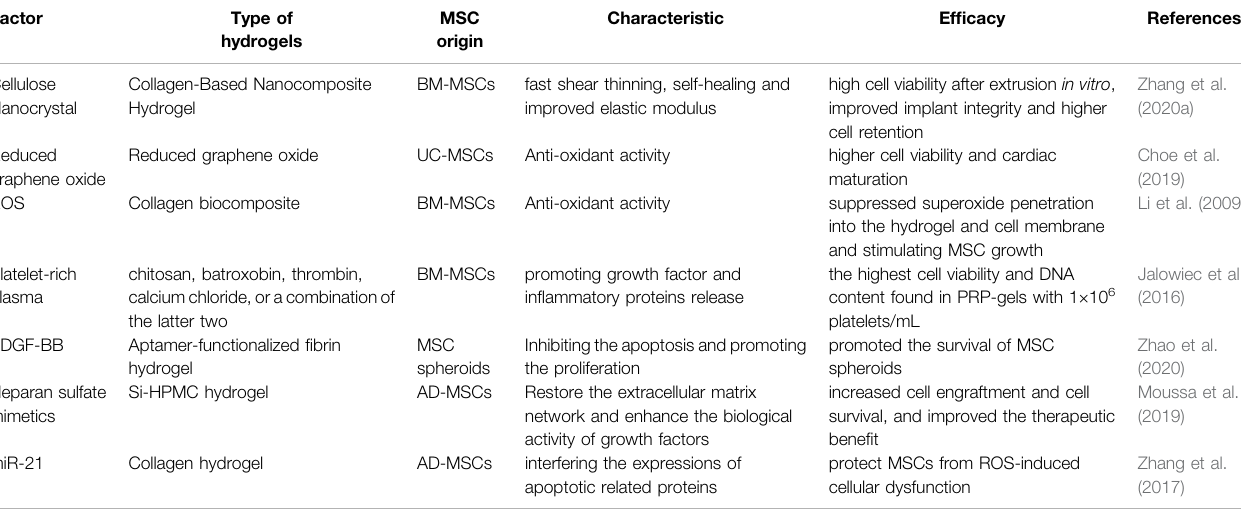
TABLE 1 | Some chemicals or bioactive factors in hydrogel promoting the viability of